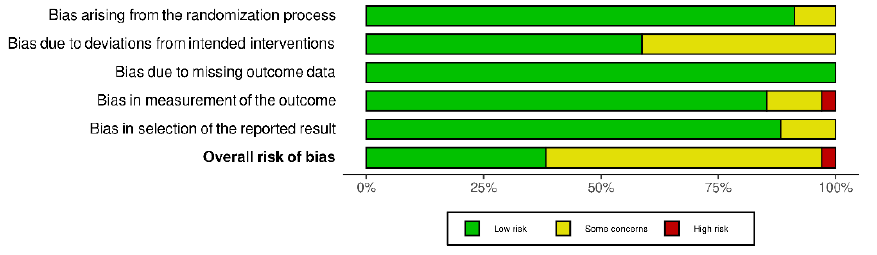
Figure 2. RoB 2 judgements for all domains [32].